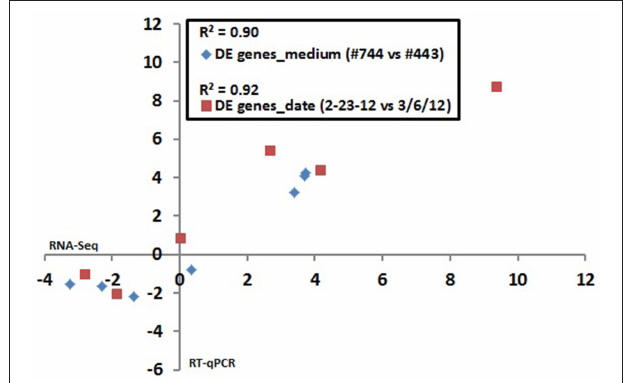
FIGURE 3 | RNA seq data validation: Correlation between RNA seq and RT qPCR results for differential gene expression in Bt strain ATCC10792 grown on different medium lots (#744–443) and dates (2/23/12–3/6/12). The log 2 transformed expression ratio values from RNA seq (x-axis) and RT qPCR (y-axis) were plotted against each other and correlation coefficient ( R 2 )-values were calculated. Seven genes plotted for medium effect: BTHUR0008_RS06920, BTHUR0008_RS03645, BTHUR0008_RS15085, BTHUR0008_RS17455,